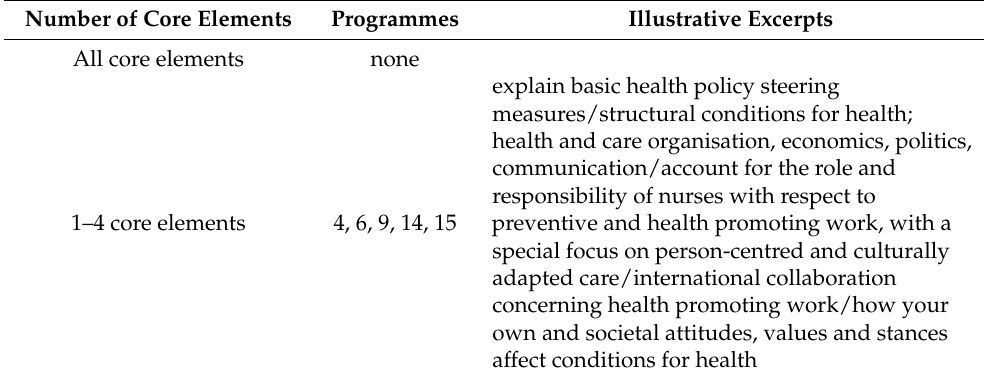
Table 5. Syllabi grouped under the theme Health and Caring.